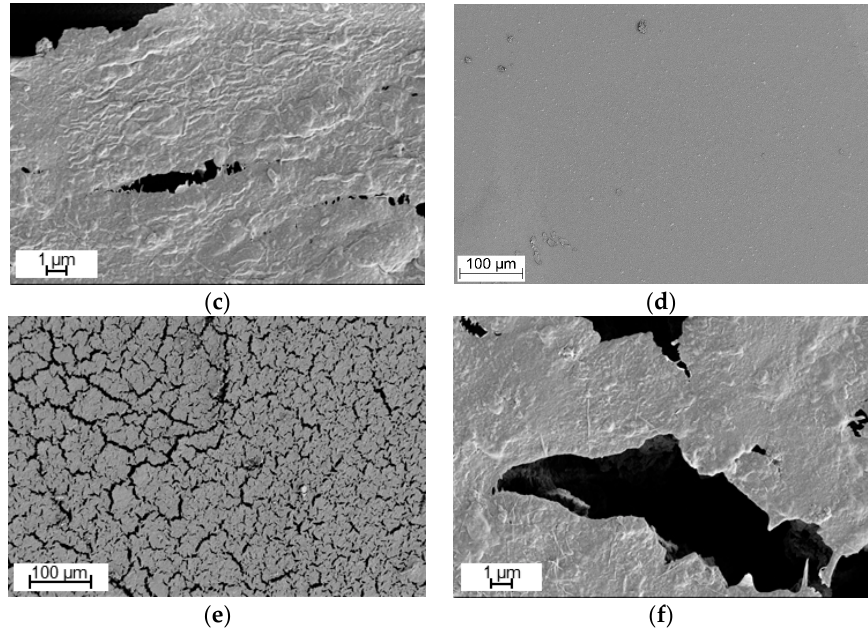
Figure 2. SEM images of TPU cube surfaces: ( a – c ) Elastollan B85A-10; and ( d – f ) Elastollan C85A-10; ( a , d ) negative control samples without enzyme; and ( b , c , e , f ) following hydrolysis by LCC at 70 °C for 200 h.